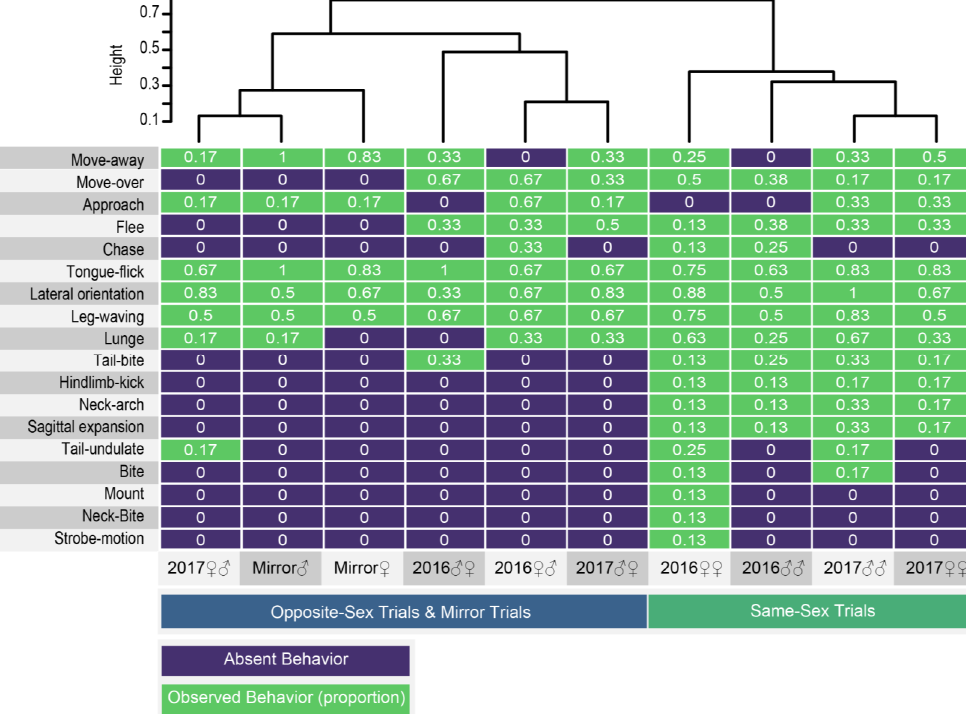
Figure 2. Mirror experiment responses are similar to opposite sex stimulus experiments. Heatmap from a presence–absence matrix of behaviors recorded in 10 conspecific stimulus experiments. Social locomotor patterns, positions, and movements are in the left. The dendrogram clustering is based on Jaccard distances from the similarity indexes on Supplementary Information 2. The numbers in white are the observed frequencies of each behavior and trial from Supplementary Information 1.